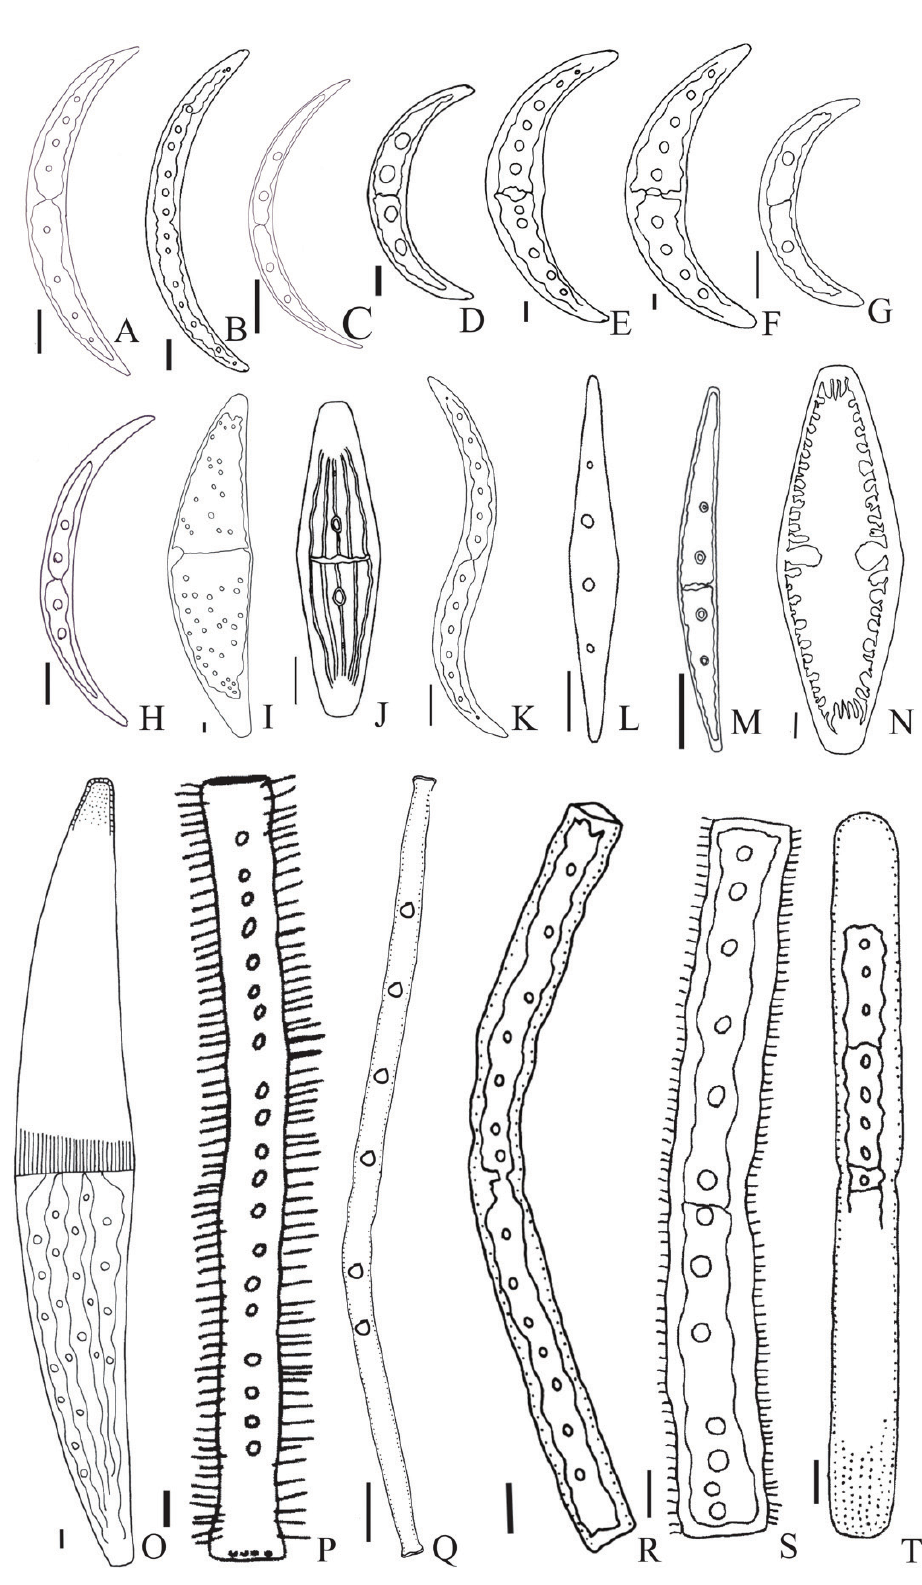
Figure 3. A : Closterium calosporum ; B : C. dianae var. minus ; C : C . exiguum ; D : C . incurvum ; E : C . leibleinii ; F : C . moniliferum ; G : C . venus ; H : C . venus var. westii ; I : C . ehrenbergii var. immane ; J : C . navicula ; K : C . tortum ; L : C . tumidum var. nylandicum ; M : C . cornu , N : Netrium digitus ; P : Gonatozygon aculeatum ; Q : G . brebissonii ; R : G . monotaenium ; S : G . pilosum ; T : Penium margaritaceum . Scar barrs = 10